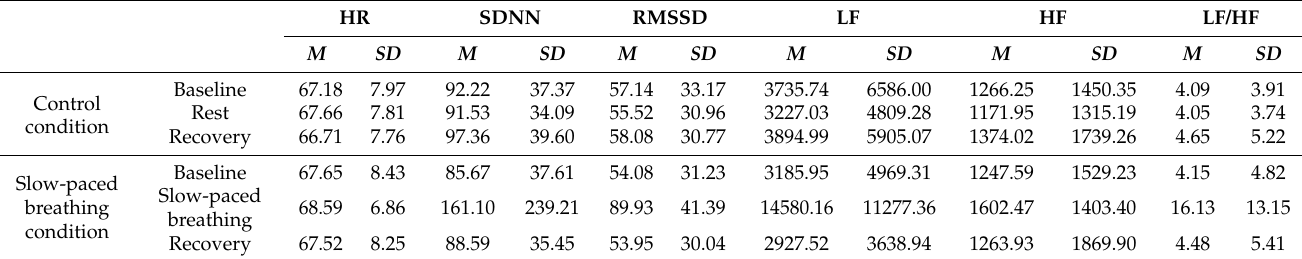
Table 1. Descriptive statistics for heart rate